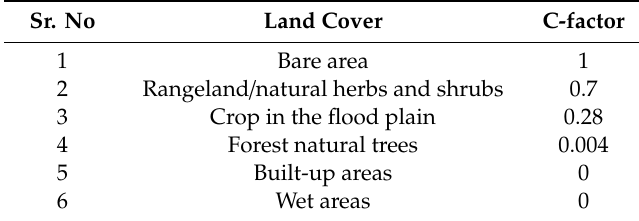
Figure 4. District Map for ( a ) C-Factor, ( b ) K-Factor, ( c ) R-Factor, ( d ) LS-Factor. Table 1. C-factor in the Chitral district.